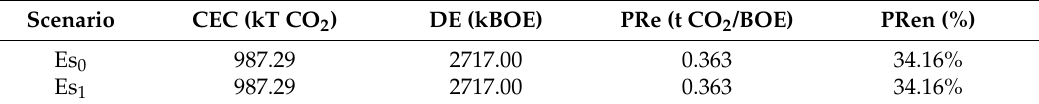
Table 18. Energy